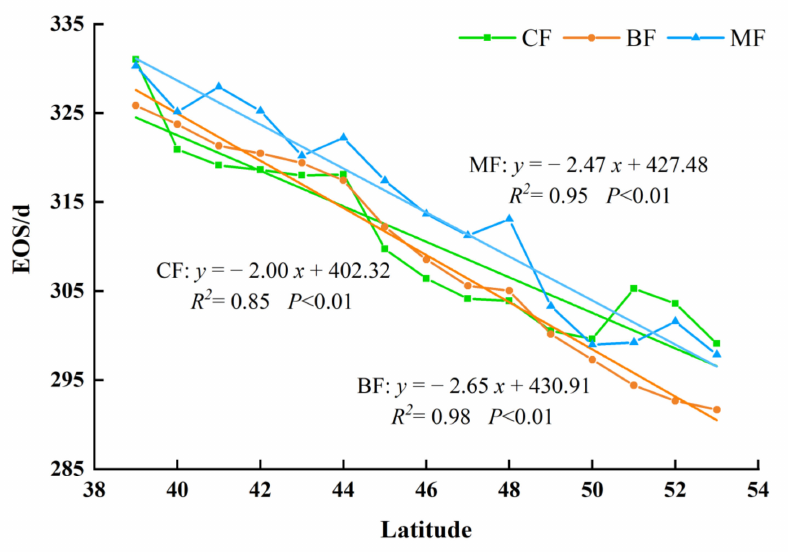
Figure 12. The variation trend of EOS in different forest types in northeast China. The variation range of LOS was affected by the EOS and SOS. The LOS of different forest types showed a significant decreasing trend with the increase of latitude (Figure 13). The LOS of BF had the greatest changing rate of 5.33 days per latitude. The LOS of MF was 4.98 days per latitude, and the CF had the smallest changing rate of 3.69 days per latitude, compared with other two forest